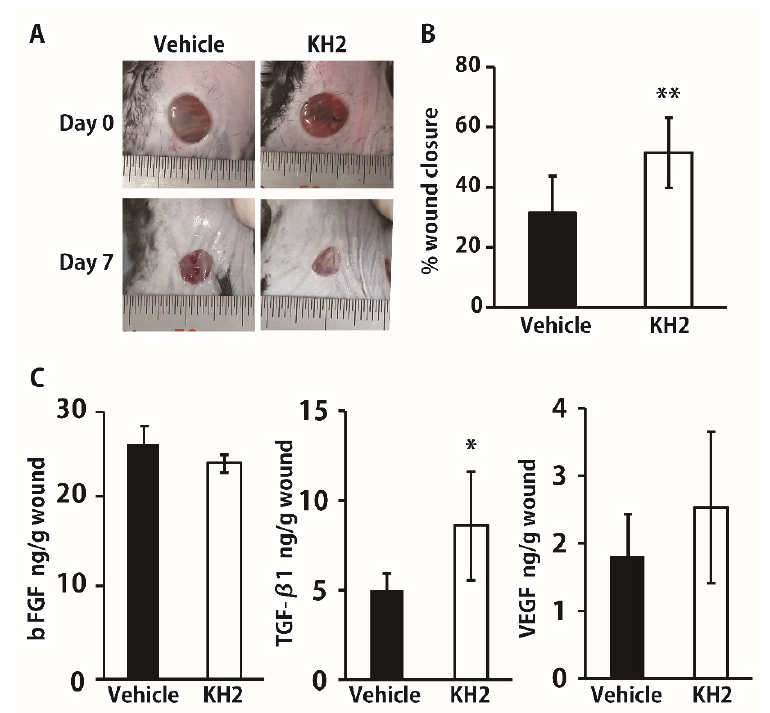
Figure 4. Effect of heat-killed KH2 administration on skin wound-healing in diabetic mice. Wounds were created on the backs of STZ-induced diabetic mice that were treated with vehicle or heat-killed KH2. ( A ) Representative photographs of wounds on days 0 and 7. ( B ) Percentage of wound closure was evaluated on day 7 ( n = 12–14 wounds), ( C ) Production of bFGF, TGF- β 1, and VEGF in the homogenates of wound tissues was measured on day 7 after wound creation ( n = 6–7 mice). Each column represents the mean ± standard deviation. The results are representative of at least two independent experiments. * p < 0.05, ** p < 0.01.